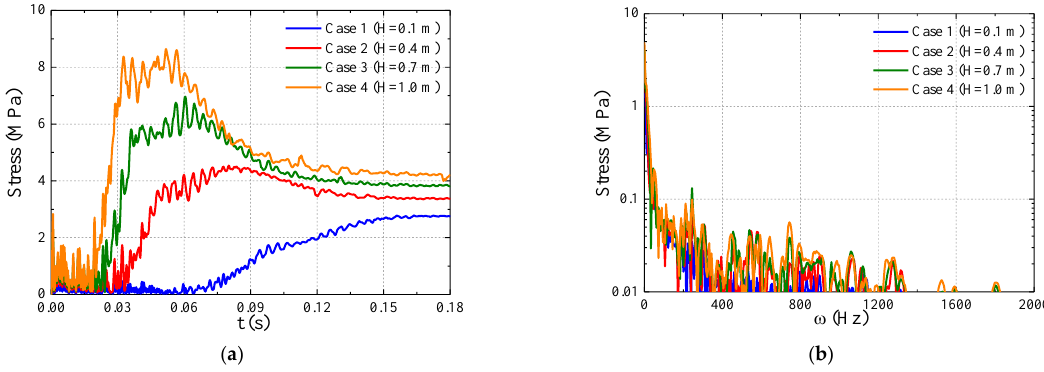
Figure 28. Structural stress at different cases (at Point S2): ( a ) time series; ( b ) frequency spectra. Figure 29 shows the vertical acceleration at bottom point S2 during the water entry process for different free falling height cases. Figure 29a,b shows the time series and frequency spectra for the case of 6-DOF released of all the FE nodes. The high-frequency components distribute at the same frequency bands for different falling height cases. The high-frequency whipping response is more obvious for the case of higher falling height. To identify the vertical vibration mode, Figure 29c,d shows the time series and frequency spectra obtained by simulation of only 1-DOF of vertical displacement released. The first three orders of natural frequency of vertical vibration can be clearly identified from the frequency spectra curves.